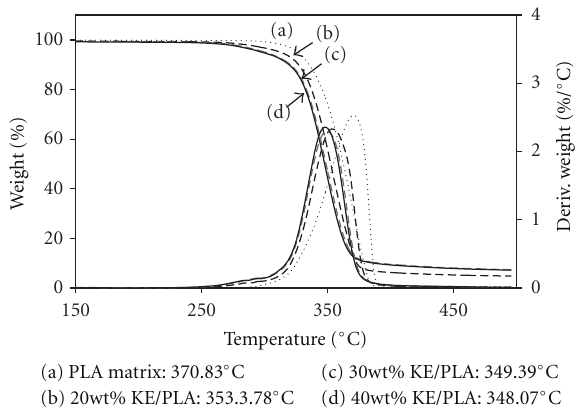
Figure 8: Thermogravimetric analysis of PLA and PLA